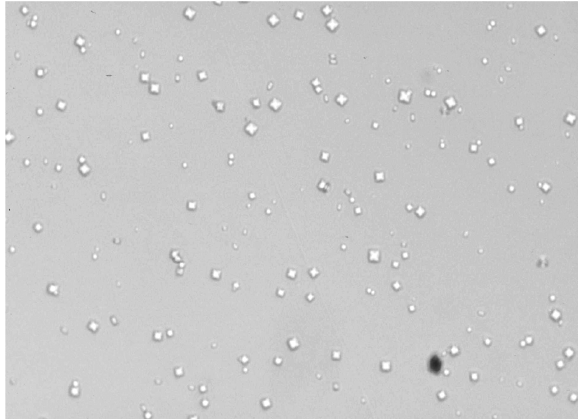
Figure 1 – Calcium oxalate crystals with typical tetragonal bipyramidal habit. (500x-magnification)